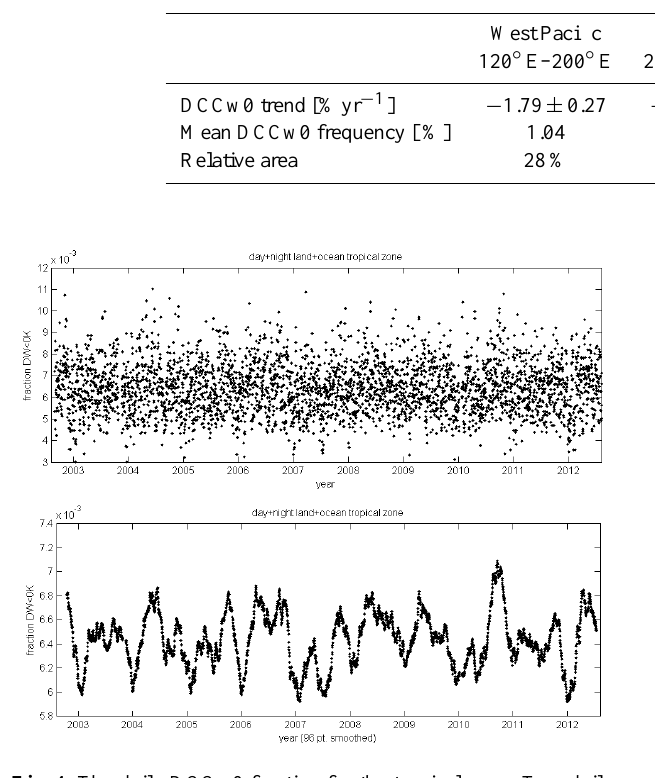
Figure 4. The daily DCCw0 fraction for the tropical zone. Top: daily data. Bottom: The same data 670 Fig. 4. The daily DCCw0 fraction for the tropical zone. Top: daily smoothed with a 96-day running average. 671 points. Bottom: the same points smoothed with 96-day running mean.